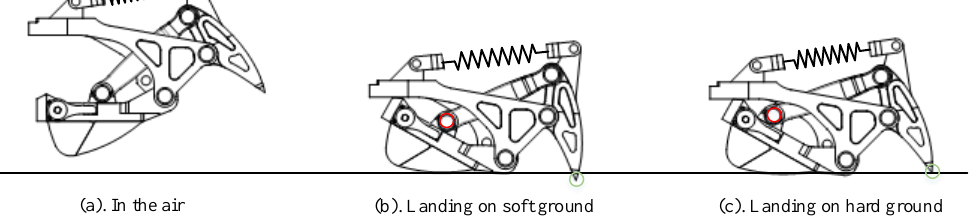
Figure 5. The different states of the bionic mechanism for different